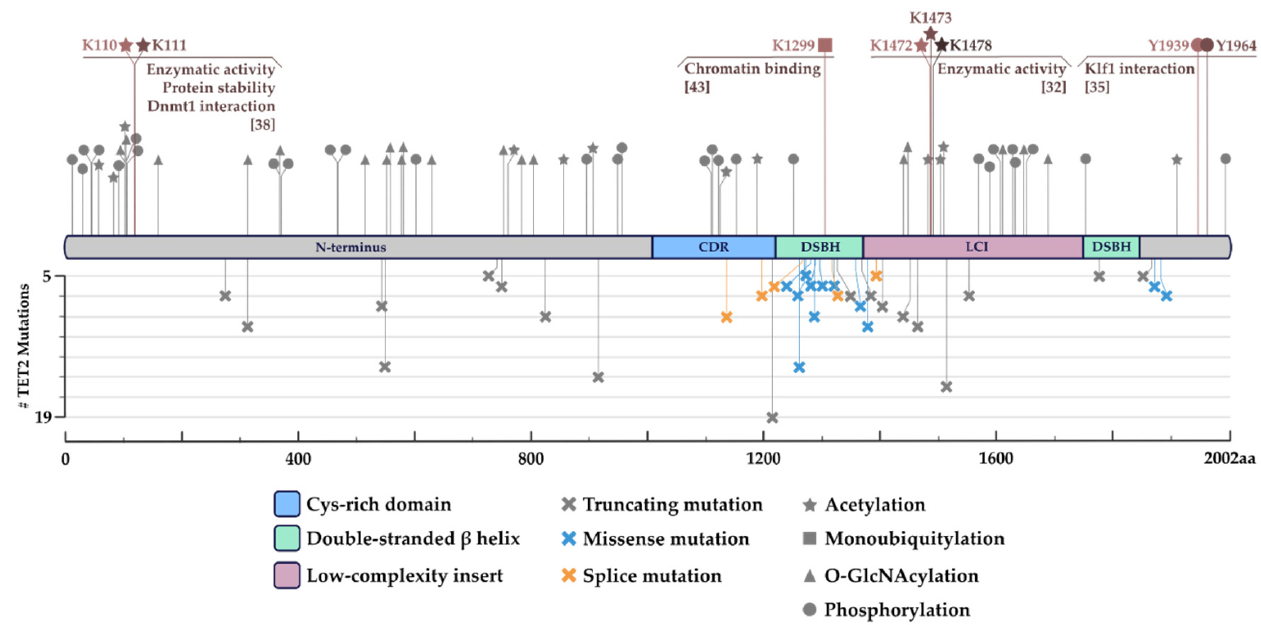
Figure 1. Schematic representation of TET2 post-translational modifications (PTMs) and most fre- quently found TET2 mutations. In the upper half, compiled PTM data based on mass spectrometry (MS) and in silico predictions [35,36,38,43,44]. In grey, proposed modifications with an undefined function. In color, fully characterized PTMs and their impact on TET2 activity. In the bottom half, a compilation of TET2 ′ s most frequent mutations and their type (truncating, missense, or splice mu- tations). Filtering was done from combined 12,845 samples from 35 studies where the mutation was found in >5 different patients. Data from ‘Myeloid’ dataset from cBioPortal (https://www.cbiopor- tal.org/, accessed on 19/01/2022) [45,46]